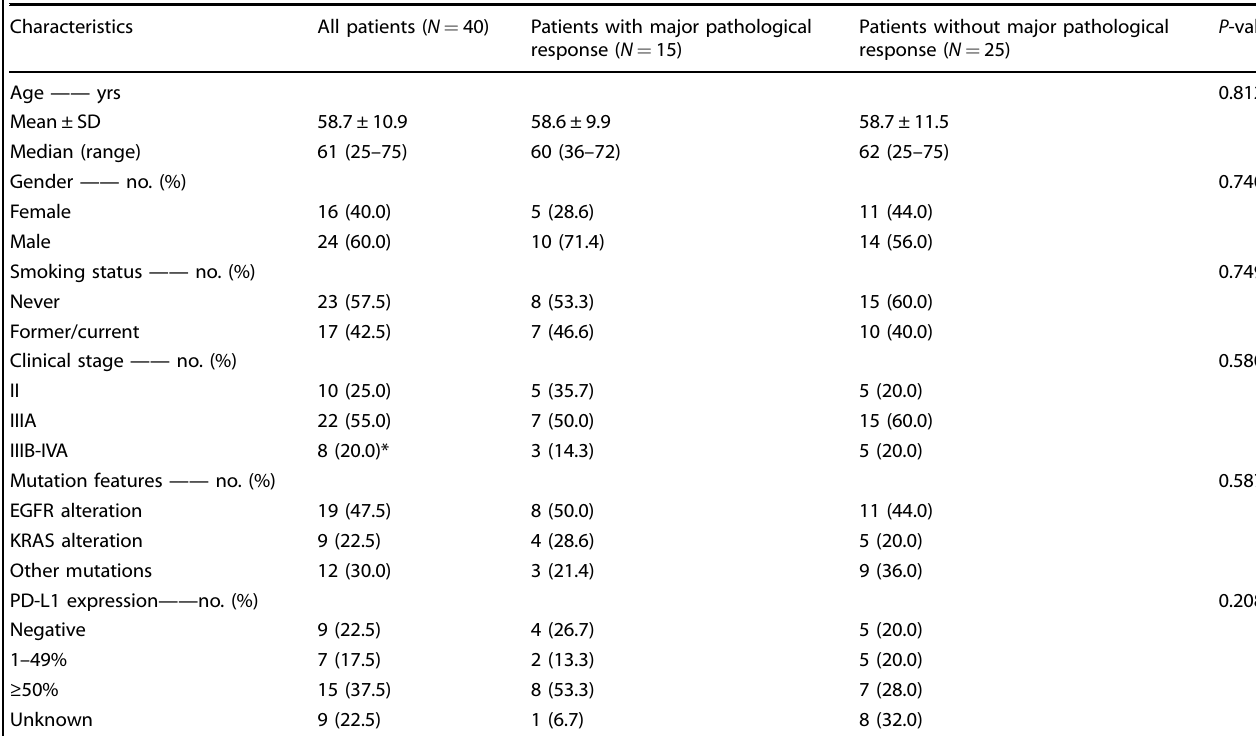
Table 1. Clincal demograchics of enrolled patients regarding MPR